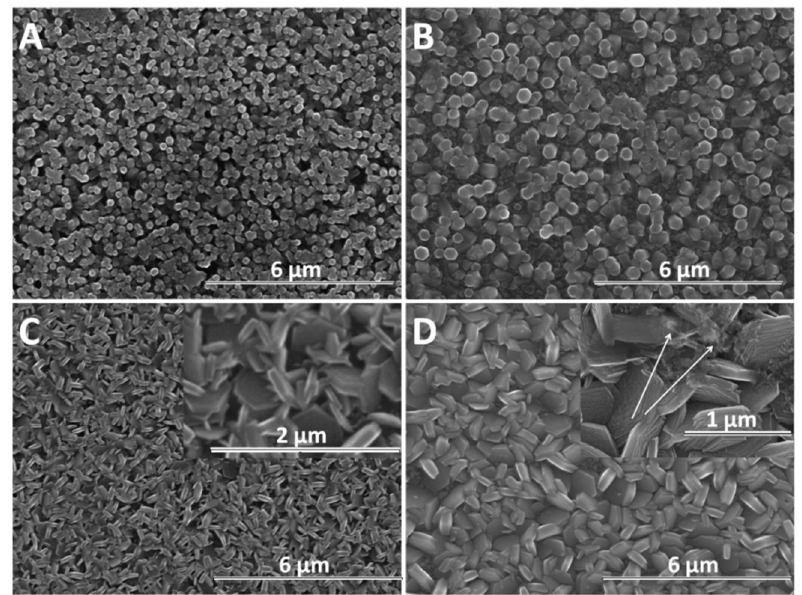
Figure 5. SEM images of ZnO electrodeposited as a function of GO content (mg L − 1 ) at − 1 V for 600 s: 0 ( A ), 2.5 ( B ), 7.5 ( C ), 10 ( D ).